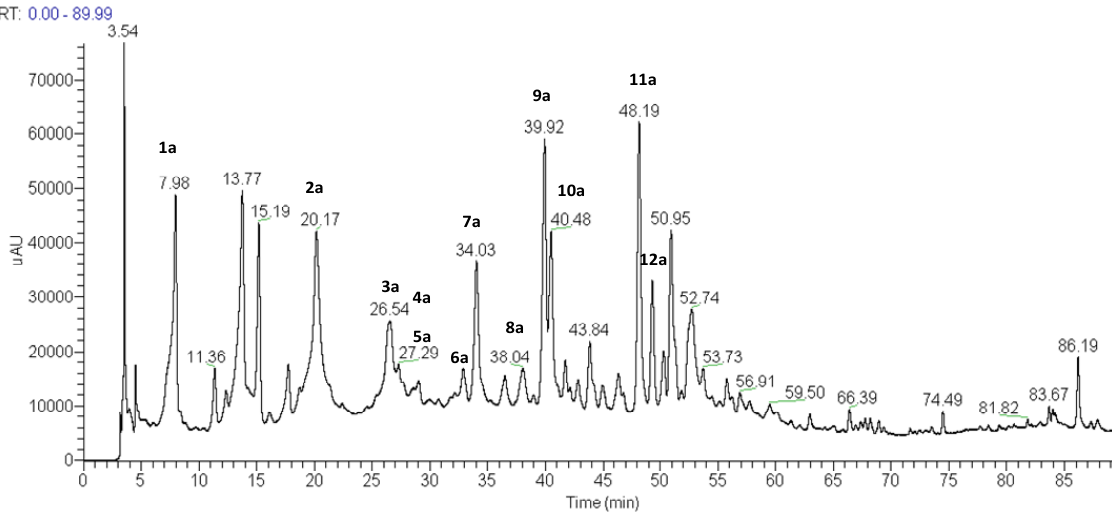
Figure 2. Total ion current chromatogram of the methanol extract of scapes of P. chiquitensis (HPLC-ESI-IT-MS n negative ion mode). For conditions, see experimental